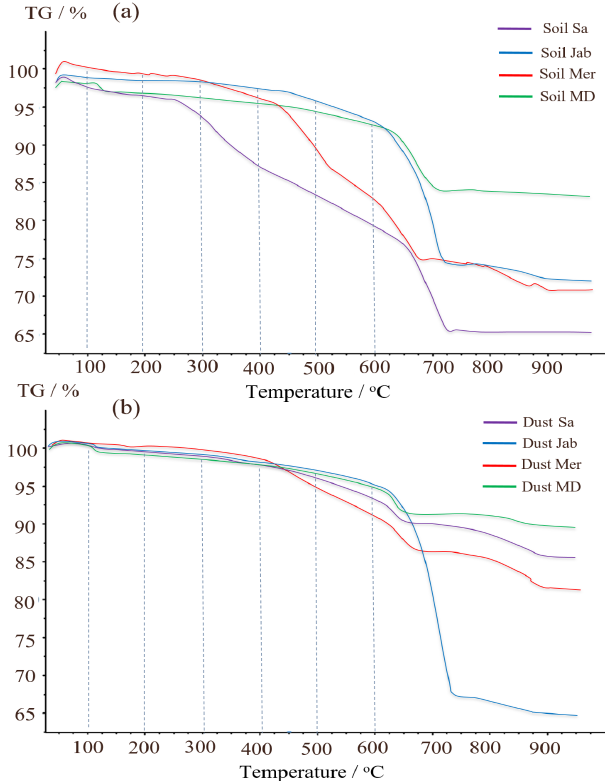
Figure 7. (a) TGA thermographs for soil and (b) for dust samples. Dashed lines delimit weight loss resulting from H 2 O (up to 200 ◦ C), organic compounds (200–550 ◦ C) separated into easily oxidizable (200–350 ◦ C) and recalcitrant (350–550 ◦ C) substances, and car- bonate compounds ( > 600 ◦